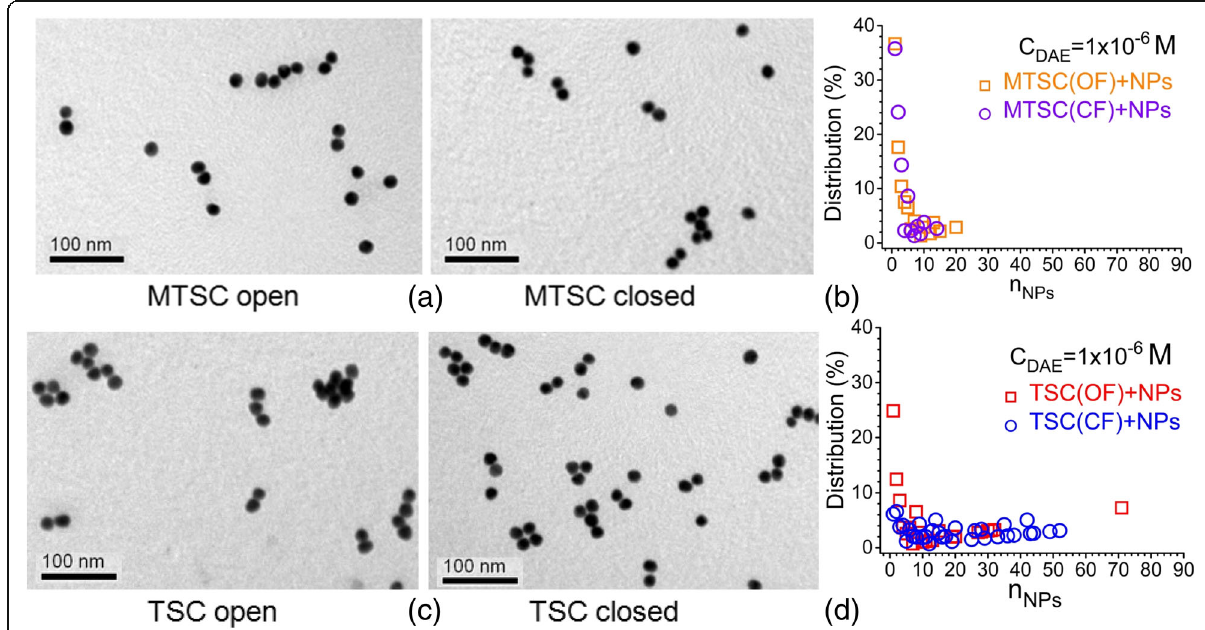
Fig. 5 TEM images of obtained colloids, where C5F-MTSC ( a ) and C5F-TSC ( c ) interacted with Au NPs in OF and CF at C DAE = 1 × 10 − 6 M. The distribution of aggregates by quantity of NPs per assembly for C5F-MTSC ( b ) and C5F-TSC ( d )